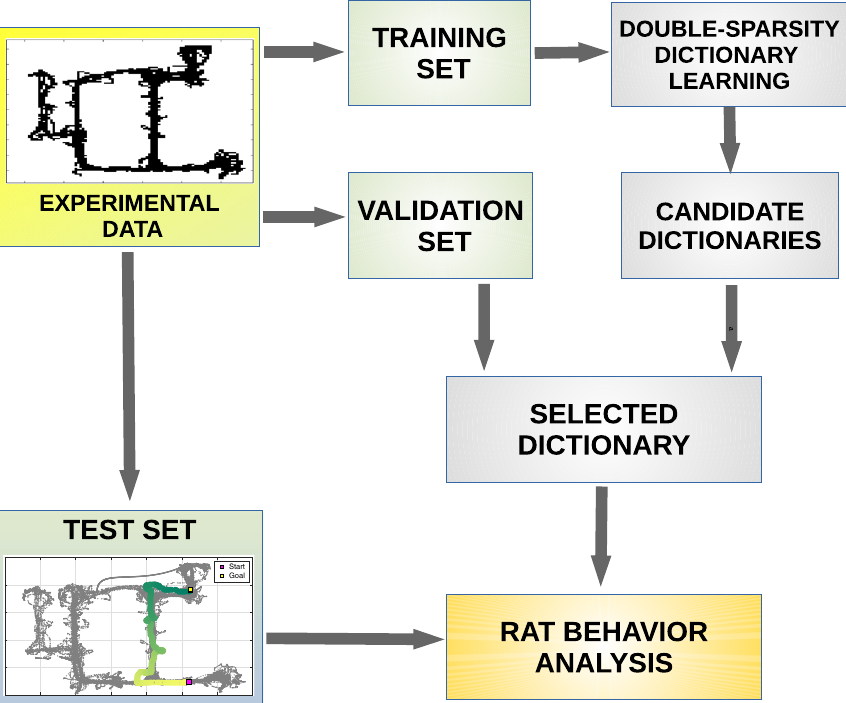
Figure 3. A framework for the analysis of rat behavior. The figure shows the workflow of the framework proposed in our paper. After collecting the experimental data, these data are split into three sets: a training set, a validation set and a test set. The training set is processed by a double-sparse dictionary learning performed with the SRSDD algorithm (see Material and methods Alg. 1), that represents data in a set of atoms—called dictionary —which are interpreted as rat motor primitives. Different candidate dictionaries are found during this process with different parameters of atom structured sparsity. Candidate dictionaries are evaluated on different sparse reconstructions performed by means of Alg. 2 on a validation set. At the end of this phase, the selected dictionary can be used on different tests to analyse rat behavior during different motor actions in the